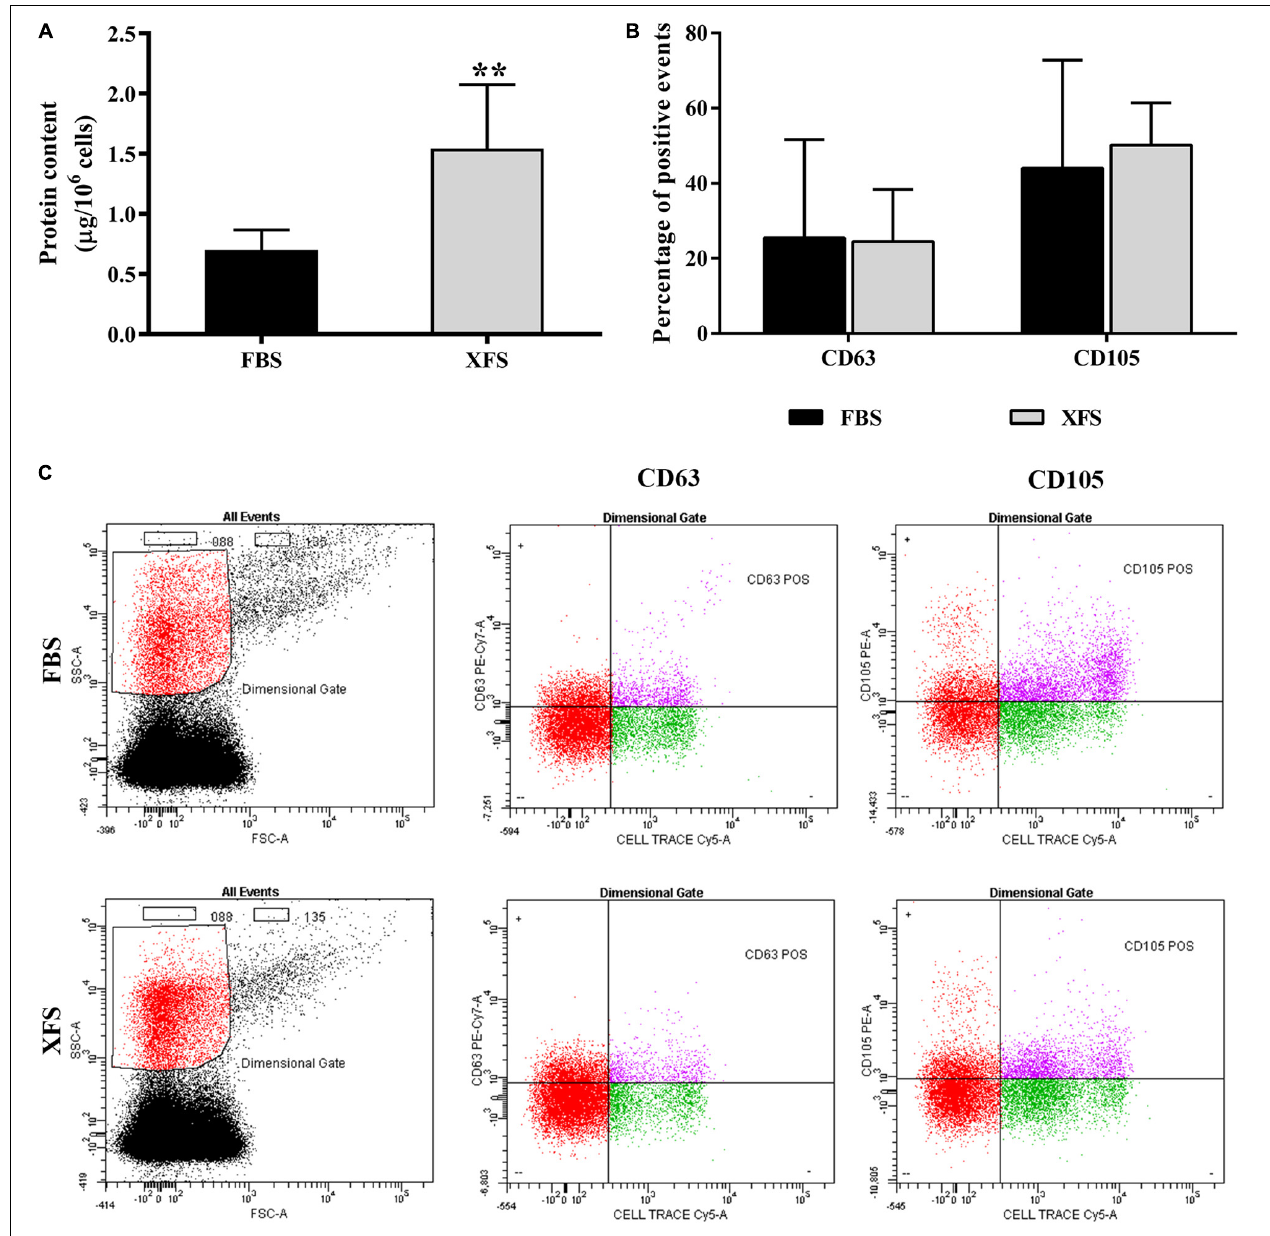
FIGURE 5 | Characterization of EVs derived from hBMSC cultured in FBS- or XFS-containing medium. (A) BCA assay of the protein concentration of FBS- and XFS-hBMSC-EVs released by 10 6 cells. Data are shown as mean ± SD, ** P < 0.01, t -test and are representative of six independent experiments. (B) Histogram showing the percentage of Cell Trace-positive EVs expressing CD63 or CD105. Data are shown as mean ± SD and are representative of three independent experiments. (C) Flow cytometry to characterize FBS- and XFS-hBMSC-EVs. Vesicles were stained by the lipophilic dye Cell Trace and specific antibodies against the vesicular marker CD63 or the MSC marker CD105. The left panel shows the physical parameters of samples. The black dots represent the noise and the red ones the dimensional gate, set on the size of reference beads. The right panels show the percentage of Cell-Trace + -CD63 + or Cell-Trace + -CD105 + events inside the dimensional gate (pink dots are double positive